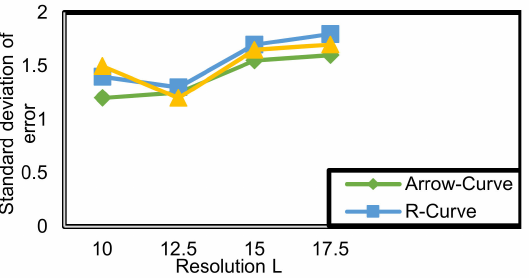
Figure 13. Standard deviation of error (SDE) corresponding to resolution (L) in Arrow-Curve model, R-Curve path model, and